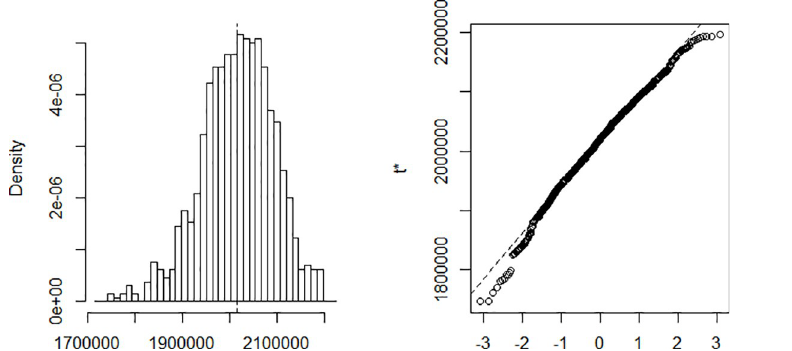
Fig 5. Bootstrap distribution of the